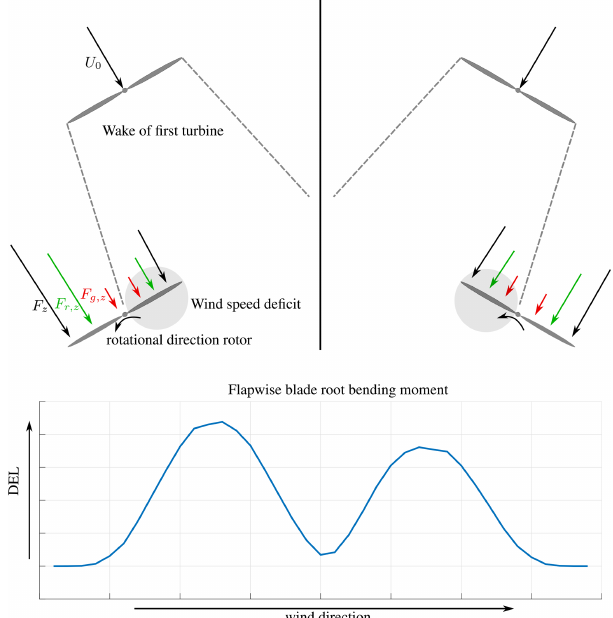
Figure A1. Schematic illustration of the flapwise blade root bending moment according to Reinwardt (2017). The aerodynamic force F r ,z , the gravitational force F g ,z , as well as the total force F z perpendicular to the rotor plane at different wake situations are marked.